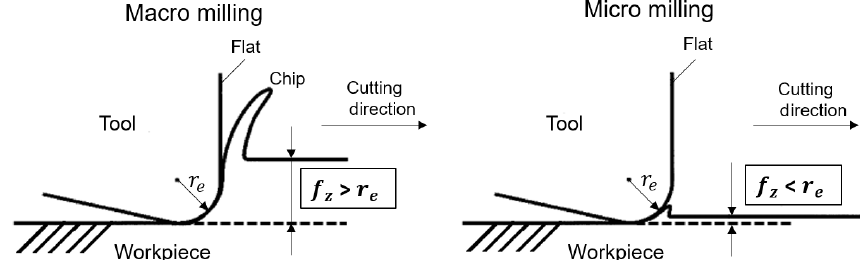
Figure 1. Schematic of macro and micro-milling process (adapted from Schaller et al.,